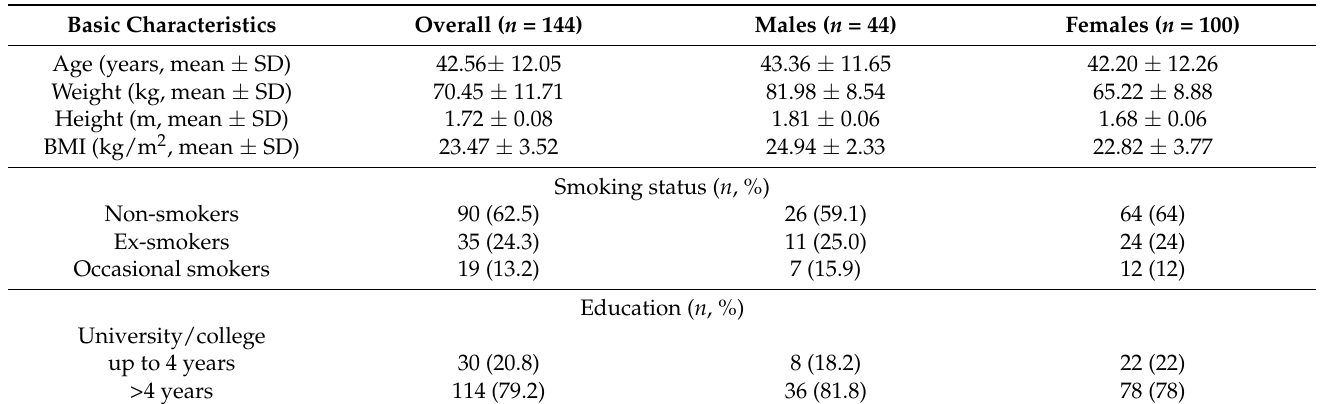
Table 1. Demographic characteristics of the study